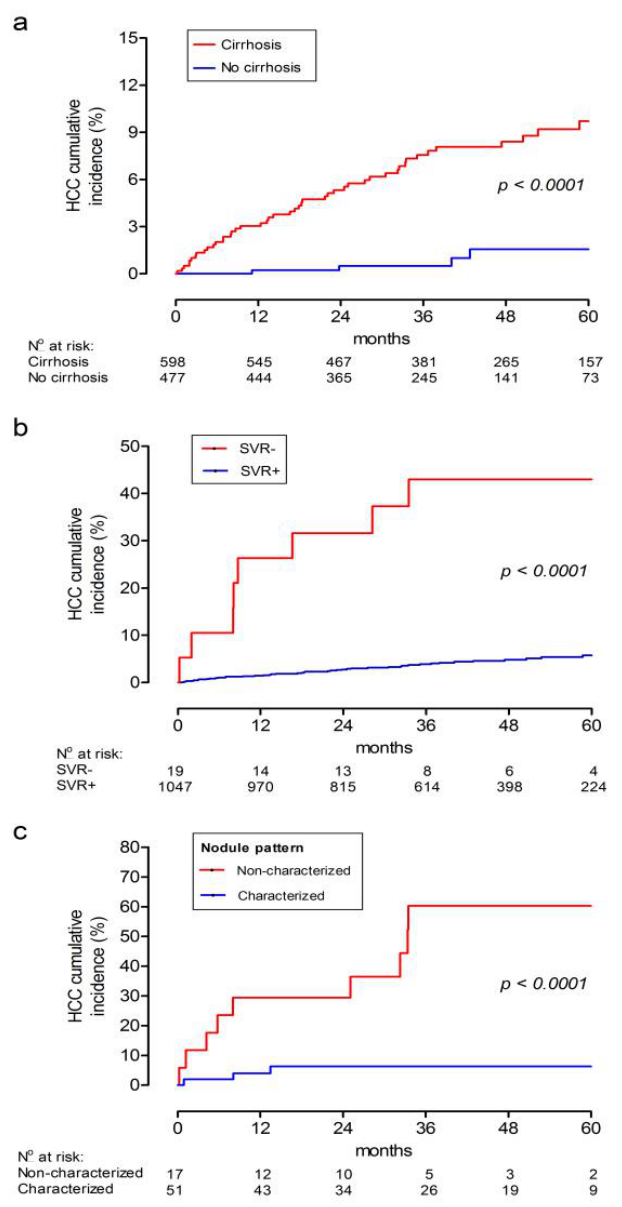
Figure 3. Cumulative incidence of HCC after the start of DAA treatment according to the presence of cirrhosis ( a ), non-SVR ( b ) and presence of non-characterized liver nodules ( c ). HCC: hepatocellular carcinoma; DAA: direct-acting antiviral agent; SVR: sustained virologic response. Of note, we found a remarkably higher cumulative incidence of HCC among patients with non-characterized hepatic nodules in the pre-treatment period. Hence, the cumulative incidence of HCC was 29.4% in patients with non-characterized nodules and 4.0% in patients with characterized nodules in the first 12 months after the start of DAAs. After 5 years, these rates were 60.3% and 6.3%, respectively ( p < 0.0001) (Figure 3c). The ROC curve analysis was performed to identify predictors of the development of HCC using TE, ALBI, FIB-4 and APRI scores before the start of DAA treatment (Figure 4). The largest area under the curve (AUC) was observed for TE (AUC: 0.79; 95% CI 0.73–0.85) with sensitivity of 86% and specificity of 61% for the cutoff of 14.3 kPa, followed by FIB-4 (AUC: 0.72; 95% CI 0.66–0.78) with sensitivity of 76% and specificity of